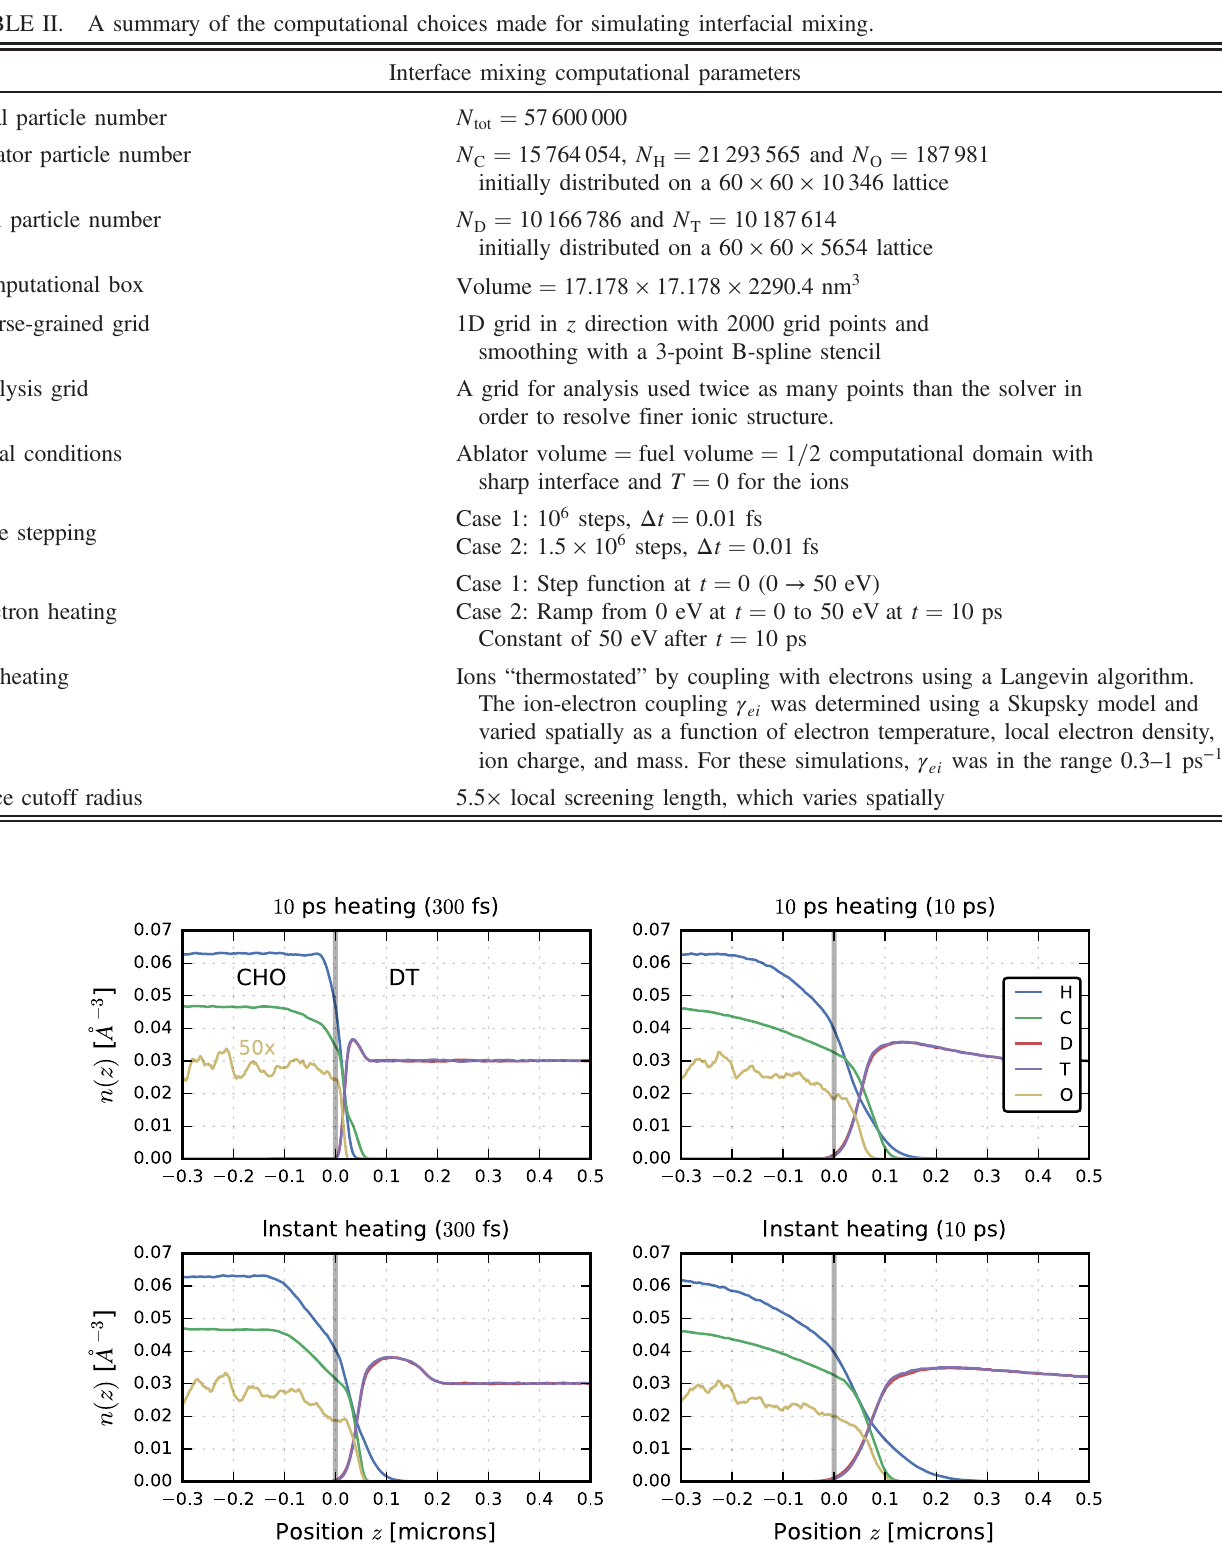
FIG. 8. Mixing. Interfacial mixing (as species density fields) is shown for the two different heating rates (slow, top row; instantaneous, bottom row) at early (first column) and late (second column) times. The gray vertical line denotes the original location of the interface (plastic on the left; fuel on the right), and the O density has been multiplied by 50 in each panel to make it visible. Note that the D and T densities remain locked together, whereas the C and H densities separate, with strong “ jetting ” of the H into the DT